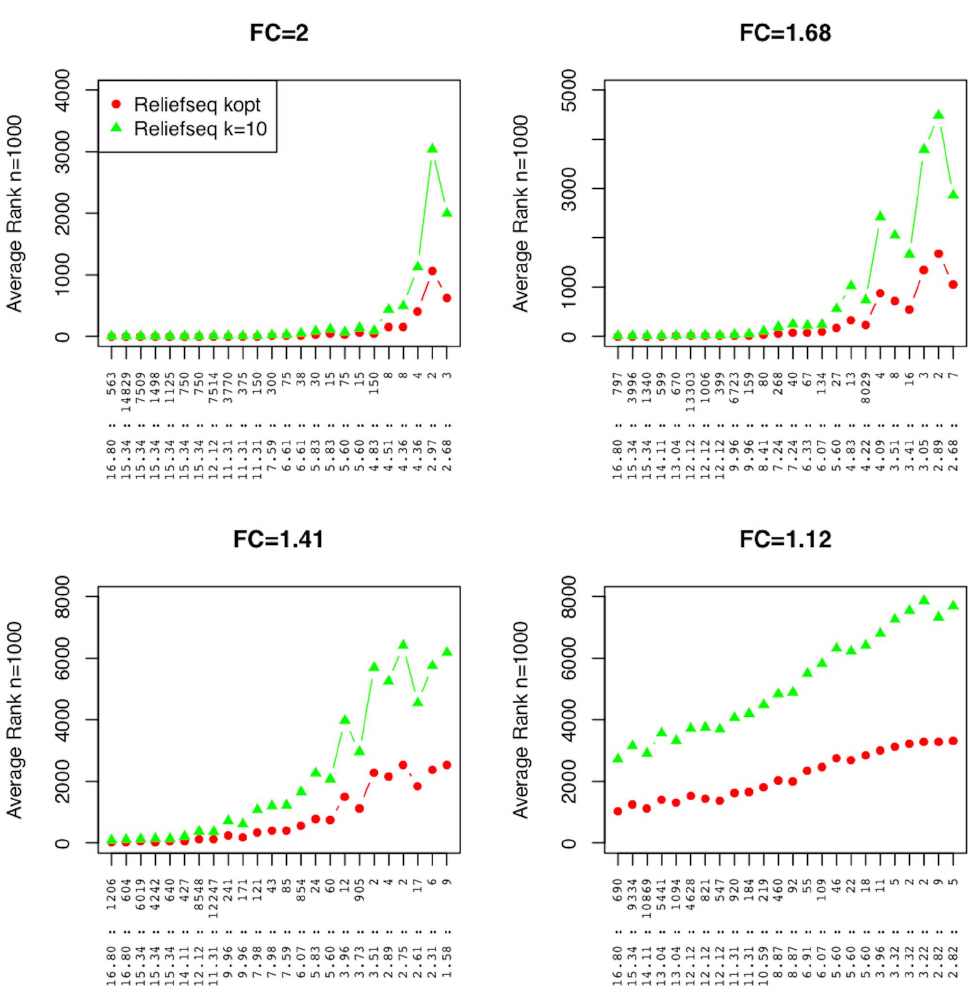
Figure 5. Main effect simulation results comparing gene-wise adaptive-k ReliefSeq with standard Relief-F (k=10). Average ranks of 96 main effects of different size for ReliefSeq with gene-wise adaptive k compared with standard Relief-F with k=10 nearest neighbors. The 96 main effect genes are simulated in each data set with a background of null genes for a total of 16,920 genes. The 96 main effect genes are split into four panels based on fold change (FC) labeled on the raw scale. The horizontal axis of each plot is labeled by the combination of negative binomial parameters ( h : m ) of the main effect gene. Genes toward the right of a panel have smaller effect size, making them more difficult to detect. Each plot point is the average rank across n=1000 replicate simulations.